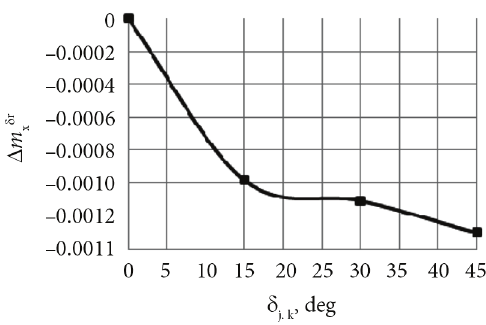
as function of δ x m